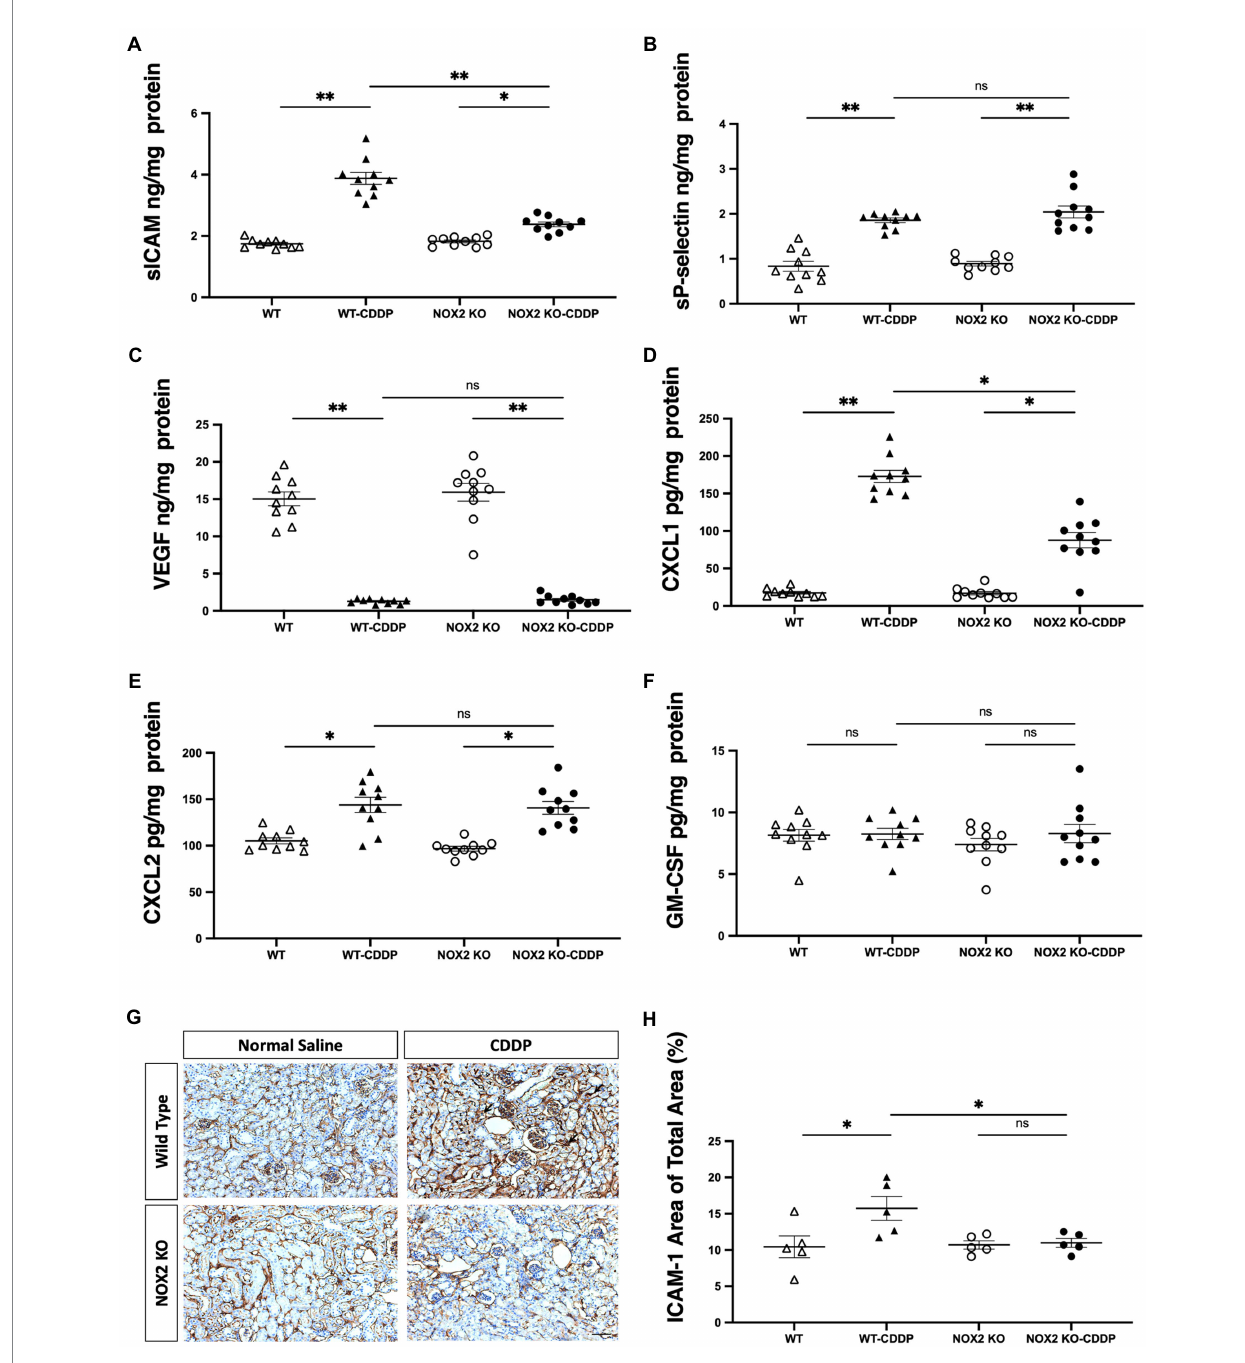
FIGURE 7 Cisplatin-induced increase in ICAM-1 and CXCL1 was reduced in NOX2-KO mice. (A,G,H) sICAM expression with Luminex assay was decreased in the NOX2-KO CDDP group compared to the WT CDDP group on day 3, and the area of ICAM-1 labeling (black arrow) through immunohistochemical staining was increased in WT-CDDP but not in NOX2 KO-CDDP mice. (B,C,F) sP-selectin, VEGF, and GM-CSF levels with Luminex assay were not significantly different between the WT CDDP and NOX2-KO CDDP groups on day 3. (D,E) The level of chemokine CXCL1 was significantly lower in the NOX2-KO CDDP group on day 3. However, another chemokine, CXCL2, showed no change between the WT CDDP and NOX2-KO groups. Data represent the mean ± standard error of five mice per group. Scale bar = 100 μ M. The experiment was repeated twice with similar